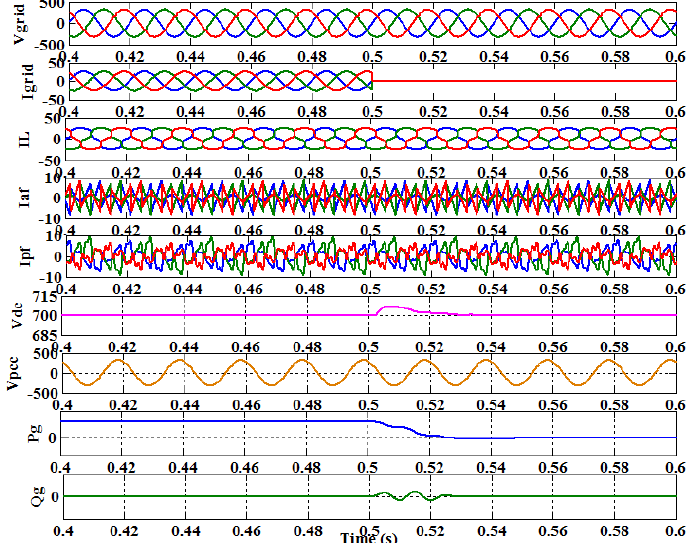
Figure 10. Grid voltage and current, Load current, Injected active filter current, Injected passive filter current, DC link voltage, PCC voltage, Active and Reactive power drawn from the grid by the load connected at PCC when switching from grid connected to islanded mode. Table 2. Performance parameters obtained in simulation in grid-connected mode.